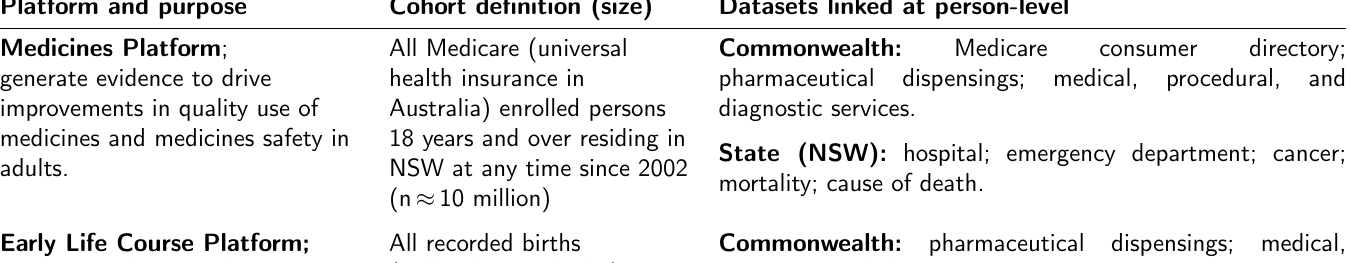
Table 1: Characteristics of two key data platforms that will be leveraged for MI-CRE evidence generation Platform and